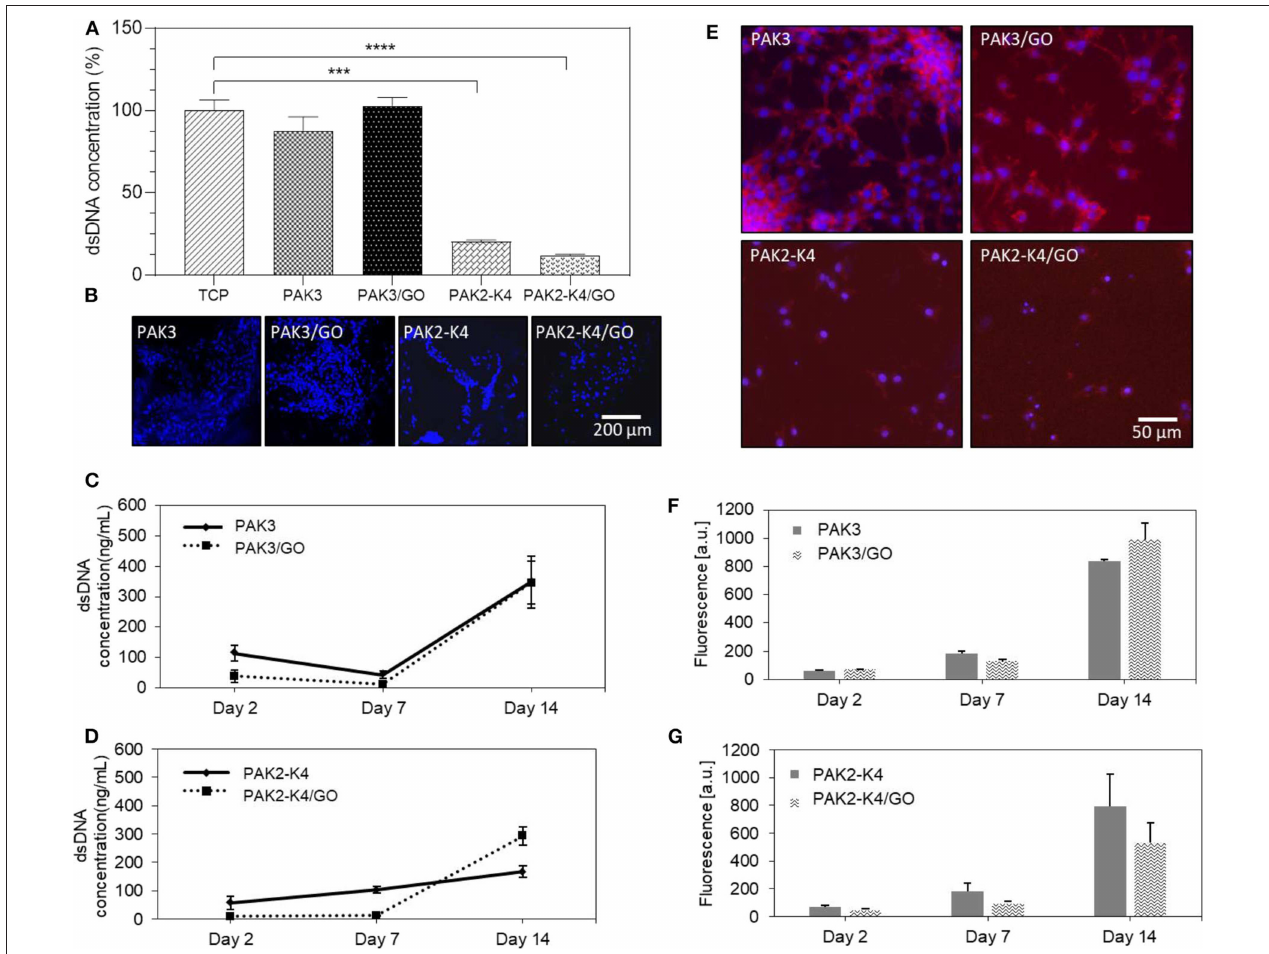
FIGURE 7 | Investigation of biocompatibility of ELR5/PAs/GO membranes. Mouse derived adipose stem cells (mADSCs) were grown on the membranes and dsDNA content (A) was quantified after 7 days in culture and normalized to TCP (100%) by PicoGreen TM assay. (B) Fluorescence microscopy images of mADSCs stained with DAPI (4,6-diamidino-2-phenylindole) after 4h of cell culture. (C,D) Proliferation studies. mADSCs were grown on the ELR5/PAK3 ± GO (C) or ELR5/PAK2-K4 ± GO (D) membranes. dsDNA content was quantified by PicoGreen TM assay. (E) Morphology studies. mADSCs were stained with Phalloidin CruzFluor TM 647 and DAPI. Images indicate a spreading morphology and intercellular connections between mADSCs growing on ELR5/PAK3 and ELR5/PAK3/GO membranes and a barely visible cytoskeleton of mADSCs grown on ELR5/PAK2-K4 and ELR5/PAK2-K4/GO membranes with minimal spreading and connections observed. (F,G) Cell metabolic activity studies. mADSCs were grown on the ELR5/PAK3 ± GO (F) or ELR5/PAK2-K4 ± GO (G) membranes, cell metabolic activity was assessed with Alamar Blue TM assay. The data suggest there is no significant difference in cell metabolic activity between either ELR5/PAK3 and ELR5/PAK3/GO nor ELR5/PAK2-K4 and ELR5/PAK2-K4/GO systems at any of the time points. Error bars represent ± SEM where **** p < 0.0001 and *** p < 0.001. The experiments were performed in